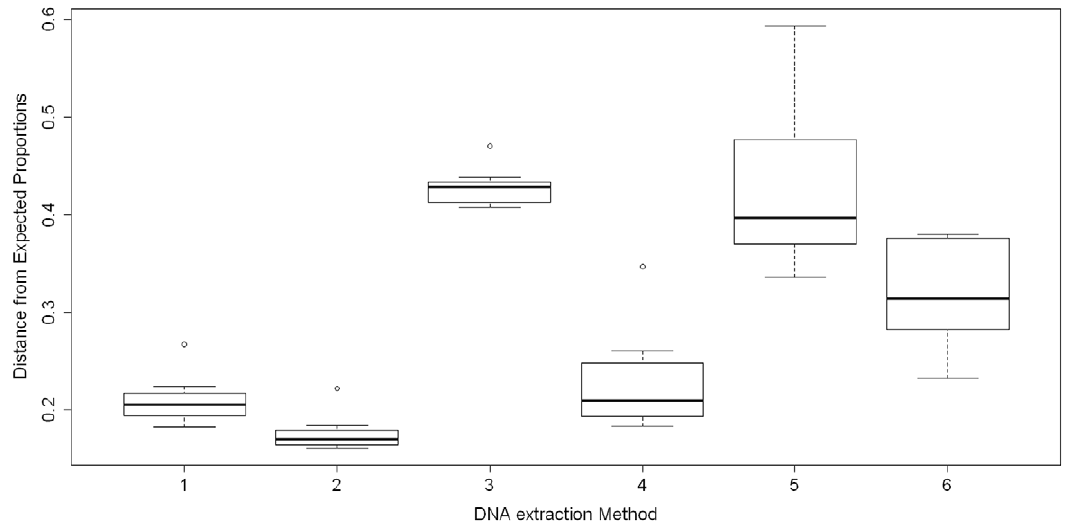
Figure 1. Boxplot of Euclidean distances between observed and expected species proportions. Euclidean distances between observed and expected proportions were calculated for each of eight replicates of each method.